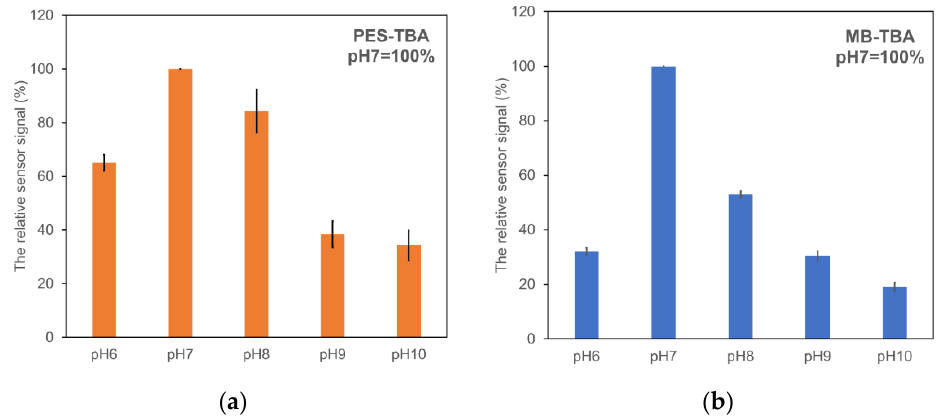
Figure 5. pH dependency of sensor signal observed at peak potential normalized to pH 7 with electrodes immobilized with PES-modified TBA ( a ) and electrodes immobilized with MB-modified TBA ( b ). Sensor signals in solution at pH 7, − 0.15 V vs. Ag/AgCl for PES-modified TBA, and − 0.25 V vs. Ag/AgCl for MB-modified TBA, are plotted against rest of range (pH 6–10) as 100%.